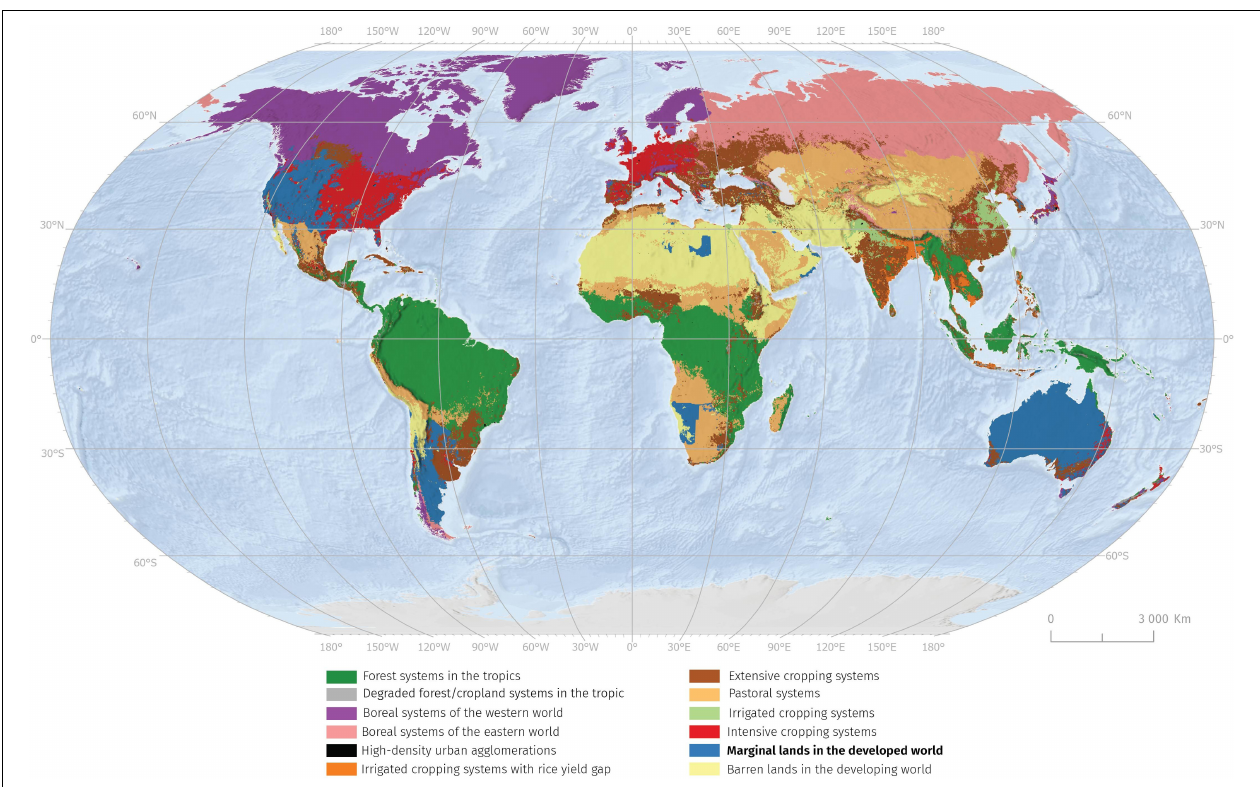
FIGURE 1 | Map shows global land system archetypes classification by Václavík et al. (2013). Within the global scale, marginal lands in the developed world cover about 9% of terrestrial